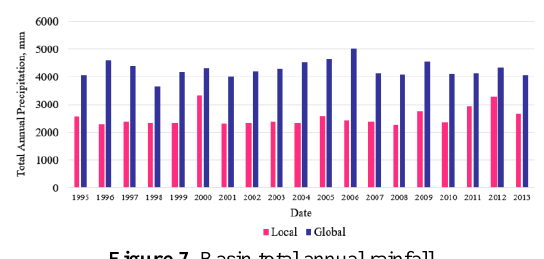
Figure 7. Basin total annual